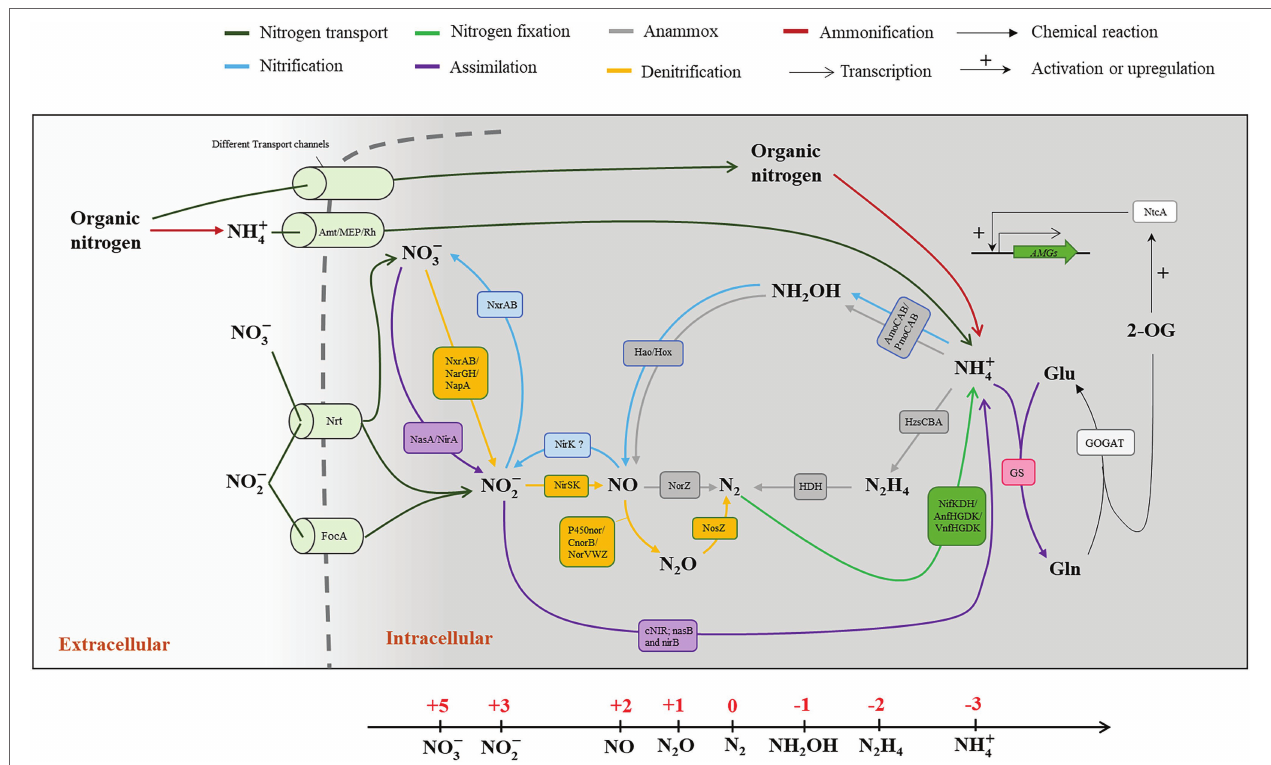
FIGURE 1 | Biogeochemical transformations of nitrogen compounds in marine microorganisms. The nitrogen cycle consists of the transformations, including nitrogen transport nitrogen fixation, nitrification, denitrification, assimilation, ammonification, and anammox. The relevant cell localizations of these pathways are divided by a cytomembrane (Gray dotted line). These pathways are found in different microorganisms rather than limited to one single cell. The main pathways in nitrogen cycle and the participating enzymes and transporters are indicated in different colors. The oxidation valences of nitrogen atom, ranging from − 3 to +5, in different compounds are indicated in a linear